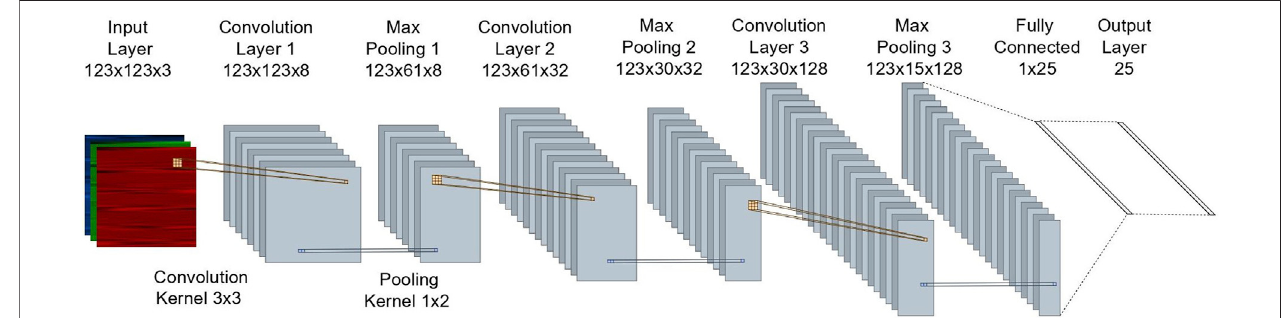
FIGURE 6 | Sample architecture for the TS-2D network using the time-series input and 2D kernel.